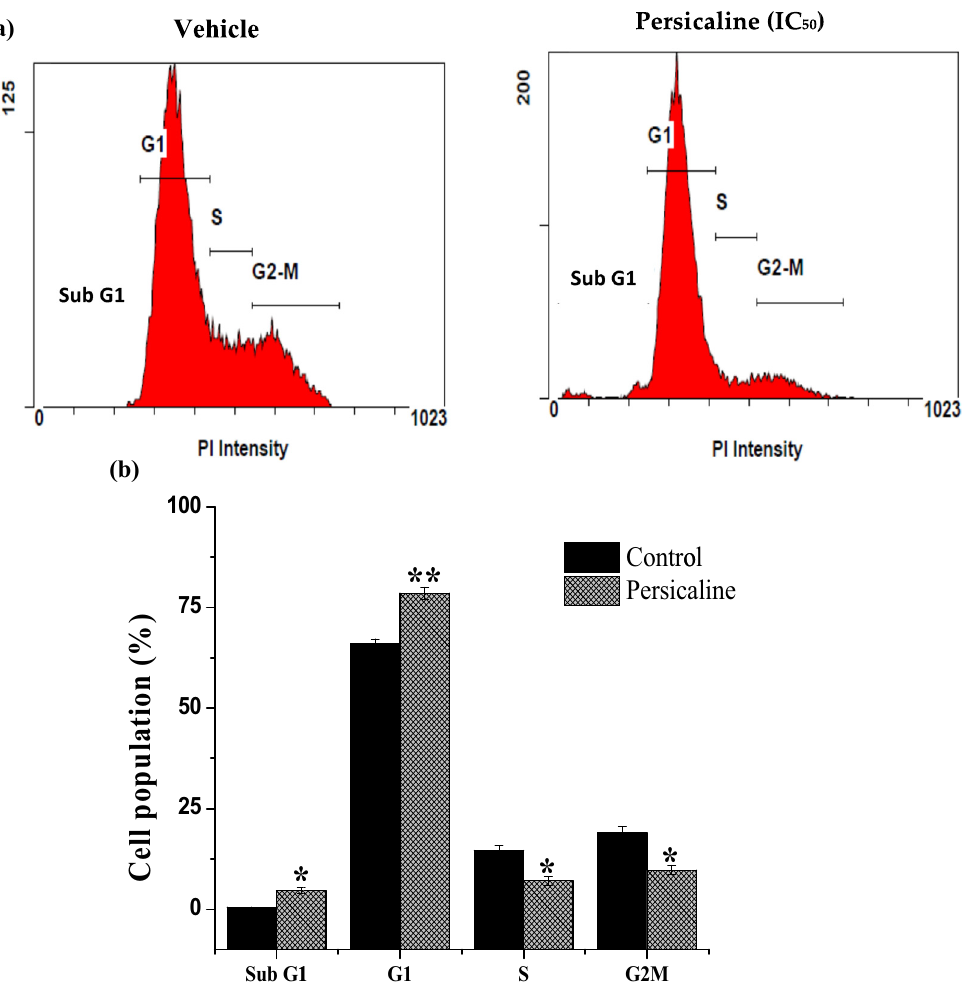
Figure 3: Persicaline - induced G1 cell - cycle arrest. MCF - 7 cells were non - treated ( dimethyl sulfoxide, control ) or treated with IC 50 ( 30 µg/mL ) and stained with PI for 24 h. ( a ) Histograms of DNA content in both treated and untreated cells. ( b ) Cell cycle phase ratio. Data are shown as mean ± SD, ** p < 0.01 as compared to corresponding